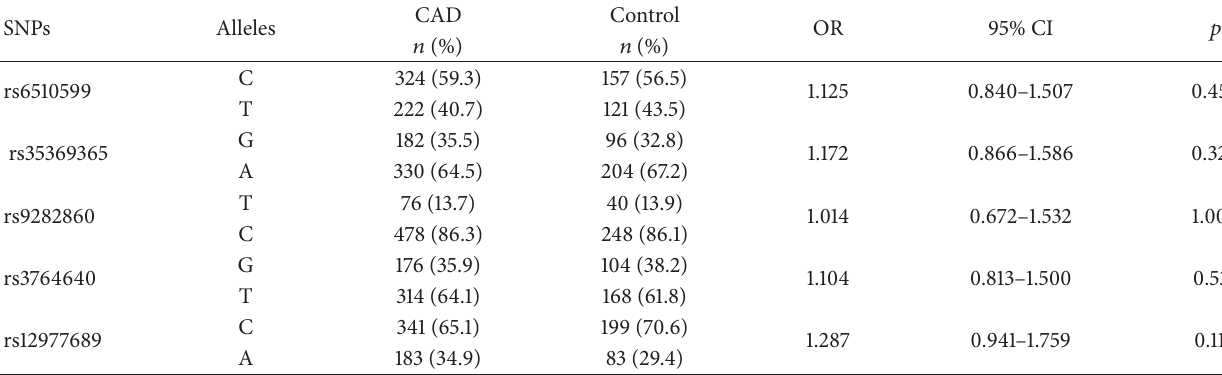
Table 2: Distributions of alleles at STK11 in CAD-positive and CAD-negative subjects.